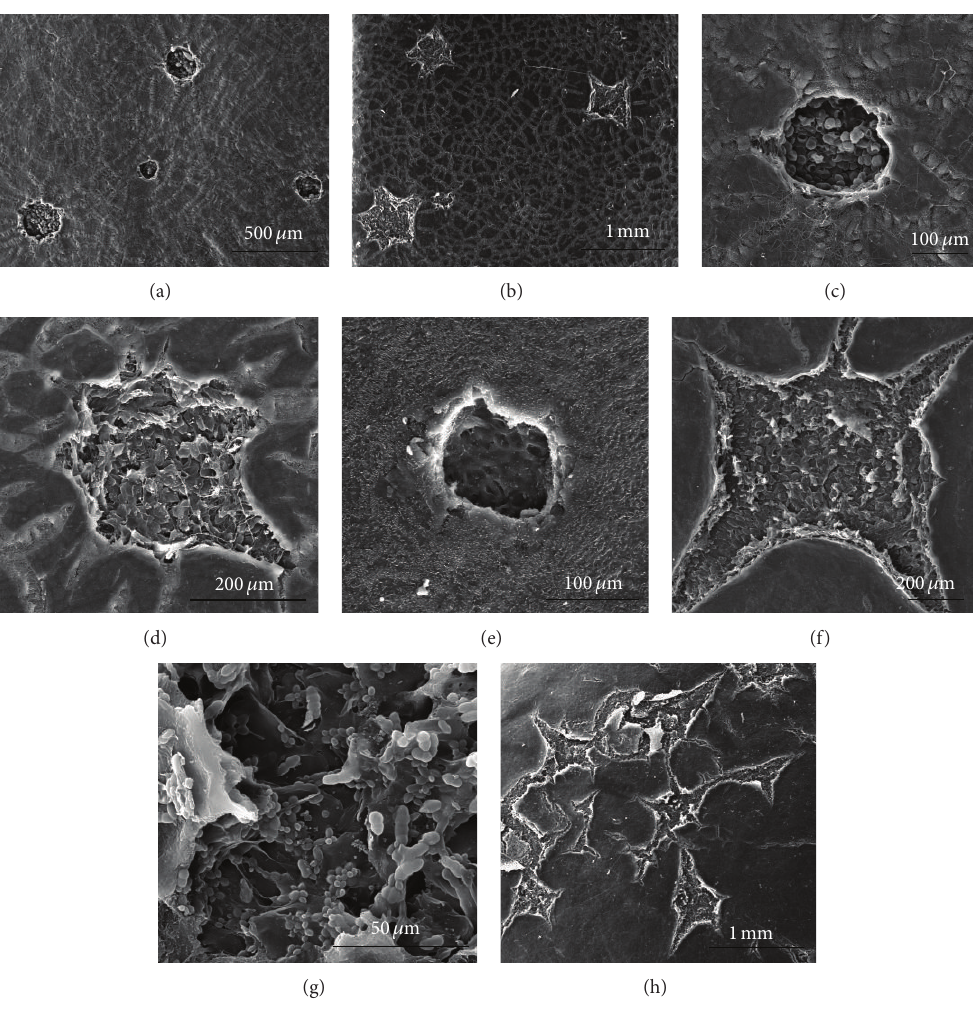
Figure 5: SEM: epidermis surface of the “Clapp’s Favourite” ((a), (c), (d)) and “Conference” ((b), (e)–(h)) fruits at the harvest maturity stage with lenticels; ((a), (c), (e)) oval lenticels; ((a), (c)) open lenticels; ((b), (d), (f)) closed star-shaped lenticels; (g) fungal spores and possibly bacterial cells visible inside the lenticel, (h), exfoliating cuticle